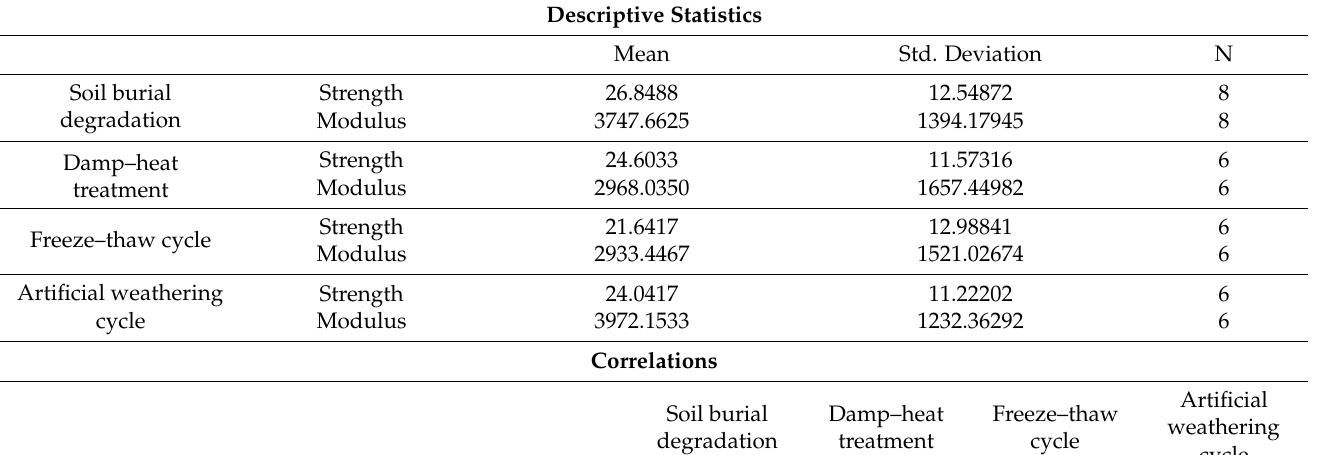
Table 1. Tensile strength correlation coefficients under different aging